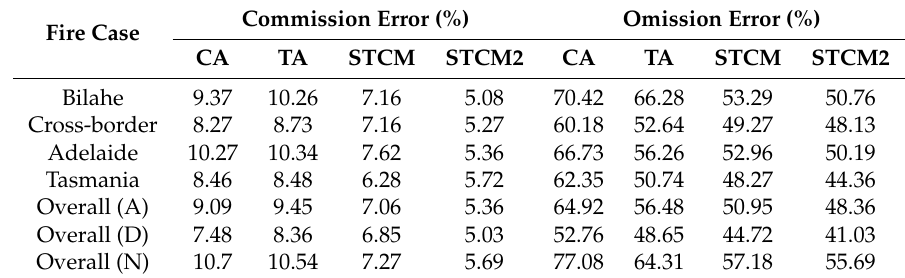
Table 5. Detection results of each fire detection method against simultanneous MODIS active fire